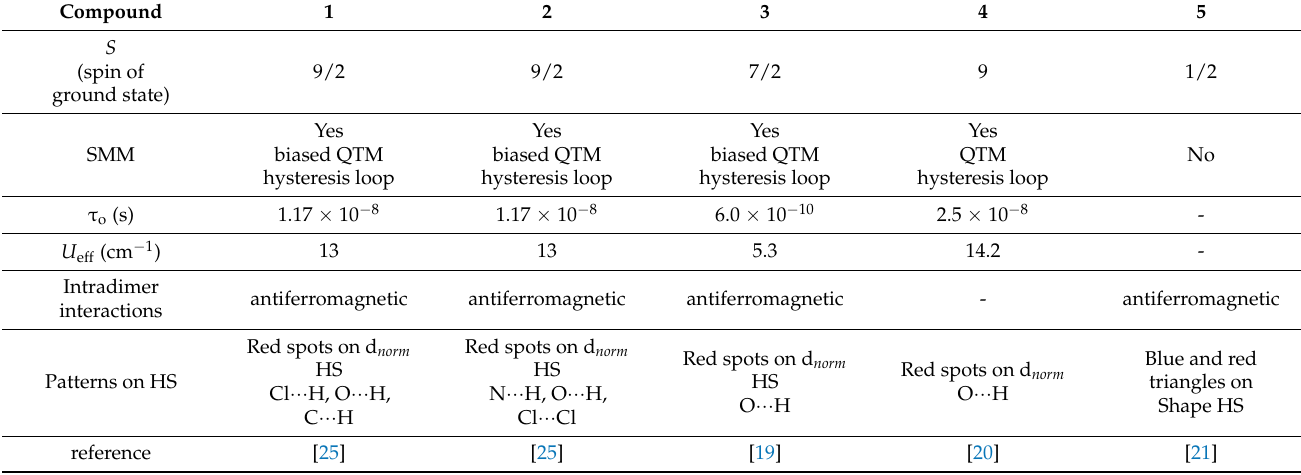
Figure 5. ( a ) A dimer of complexes presenting π ··· π type of intermolecular interactions with one molecule to be surrounded with a shape decorated HS and the other in a ball and stick presentation for compound 5 . Contribution of the most interesting types of interactions, ( b ) H ··· H, ( c ) C ··· H/H ··· C, and ( d ) O ··· H/H ··· O derived from the fingerprint plot of compound 5 . The outline of the full fingerprint contribution is shown in gray. Table 2. Physical parameters and patterns on HSs of the studied compound